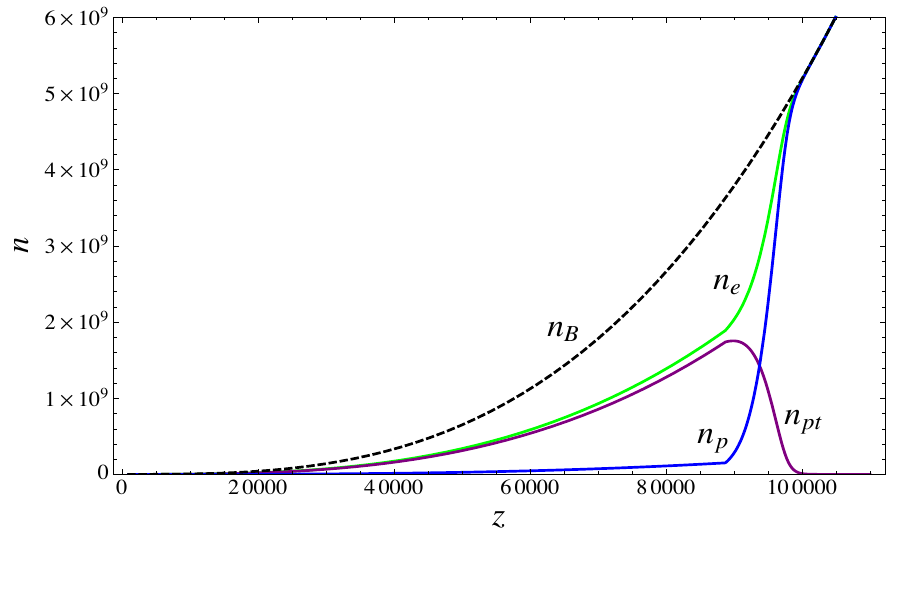
Figure 2. Evaluation of the equilibrium Saha–Boltzmann ptre combination displaying the proton density n in blue, the electron density n p n = 1 , h = 0 . 71 , T in dashed-black, with Ω B M